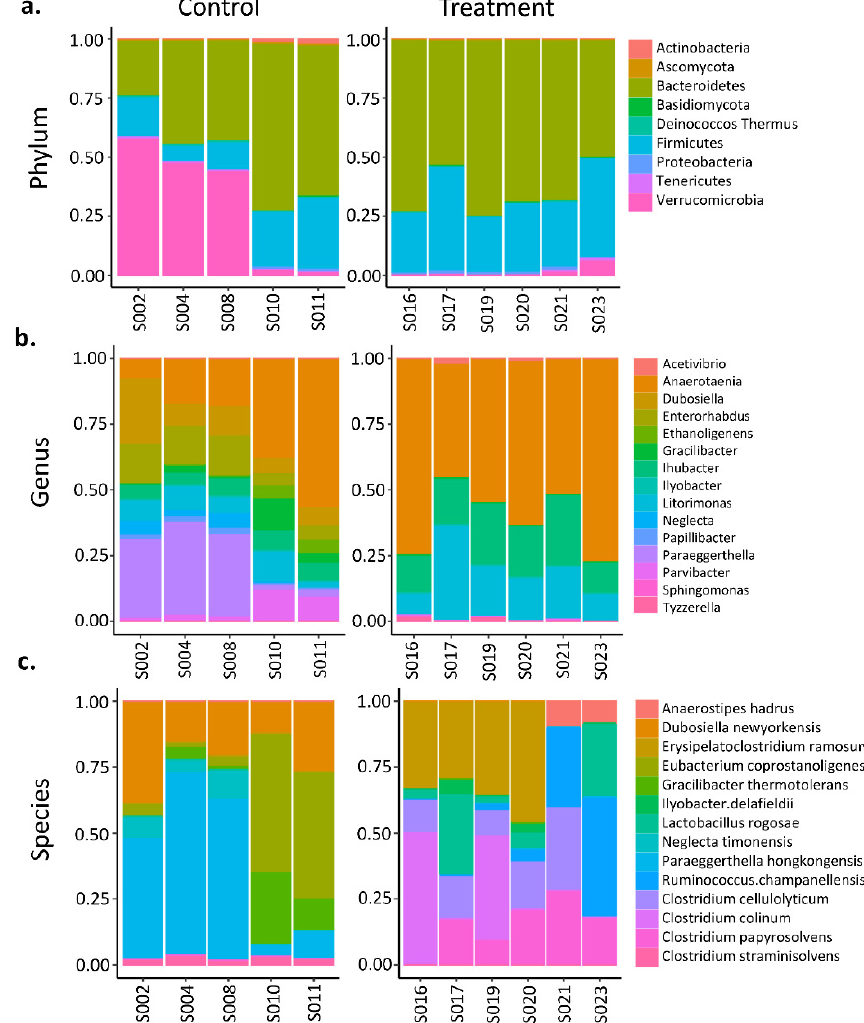
Figure 6. Relative abundance comparisons in the GI microbiota between dysbiosis (treatment) ( n = 6) and control ( n = 5) groups ( a ) at the phylum level, ( b ) gene level, ( c ) and species level.